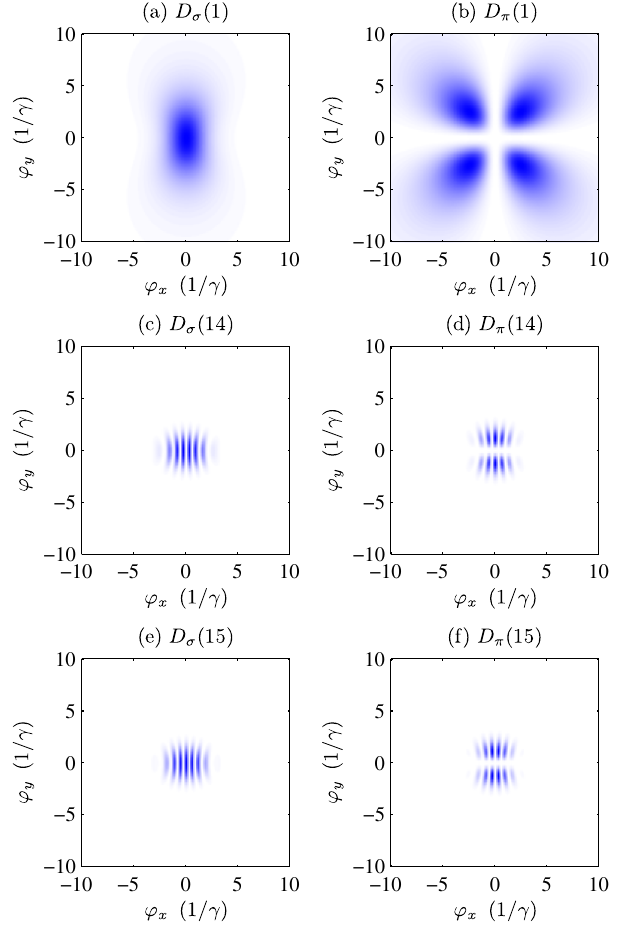
FIG. 1. Analytical single-electron angular distribution of un- dulator radiation for an electron in a horizontal, planar undulator. Both D σ ð n Þ and D π ð n Þ linear polarization modes [Eq. (3), (4)] are illustrated for undulator harmonics n ¼ 1 ; 14 ; 15 [14]. Electron and undulator parameters are summarized in Table I. The angular distribution is plotted in terms of horizontal and vertical opening angles φ x ; φ y , in units of the angle 1 = γ . For high undulator harmonics, the distribution resembles a narrow interference pattern.